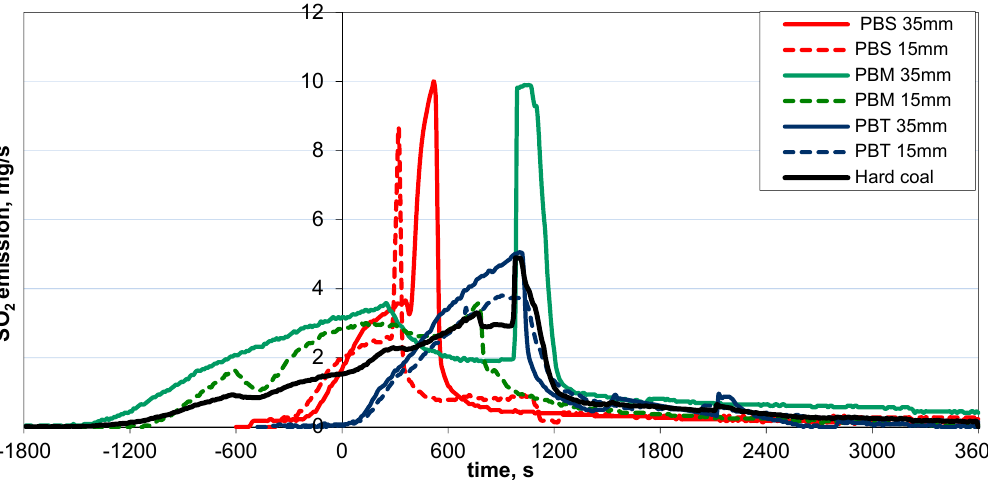
Figure 4. Variations of NO emissions during combustion of fuels.